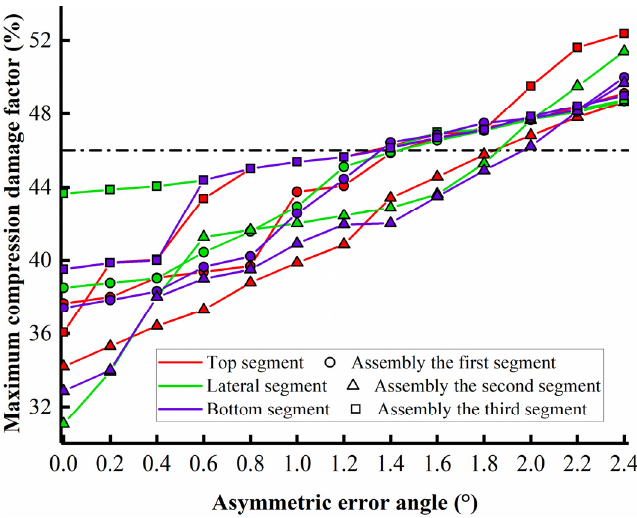
Figure 20. Maximum compression damage factor in the presence of lateral deflection.